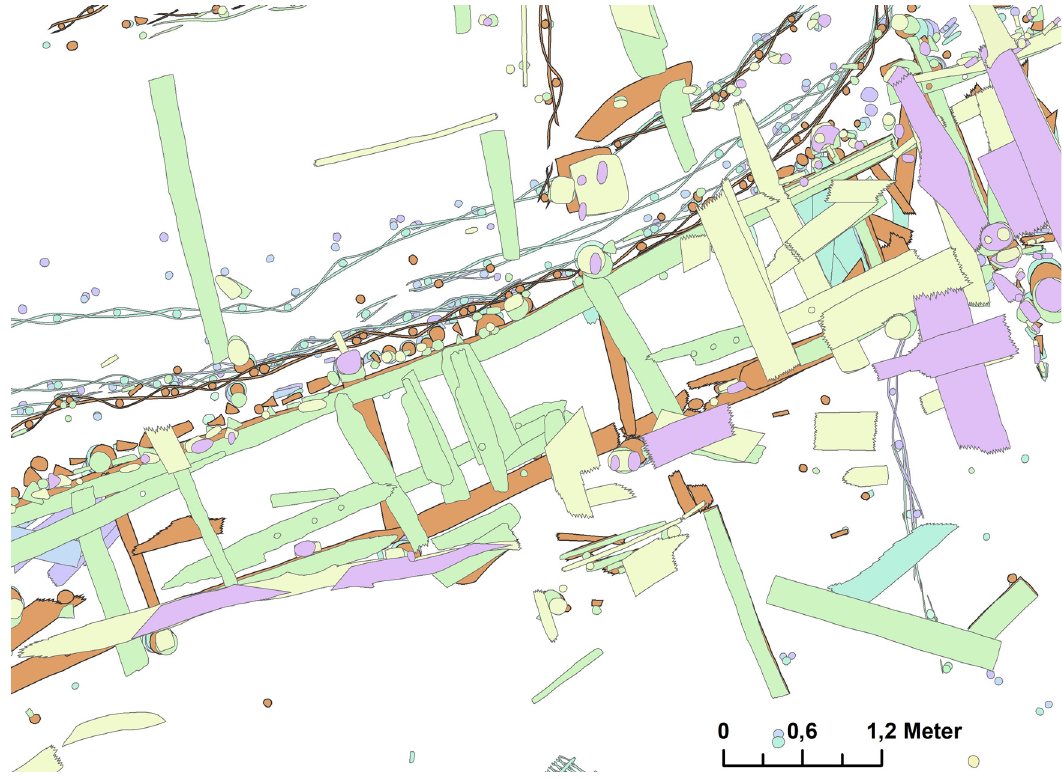
Figure 8: After completion of step 10 and before step 11: all wooden features in trench 9 have been digitized. Each color equals a layer ( Graphics: F. Rösch )